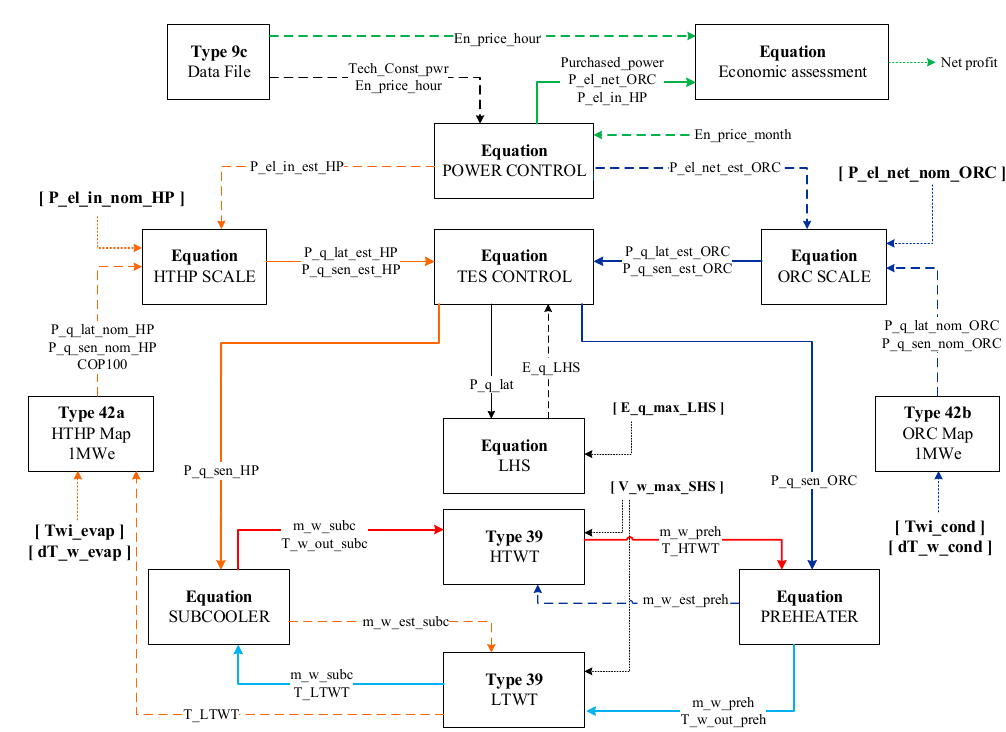
Figure 3. General layout of the TRNSYS-CHEST model.